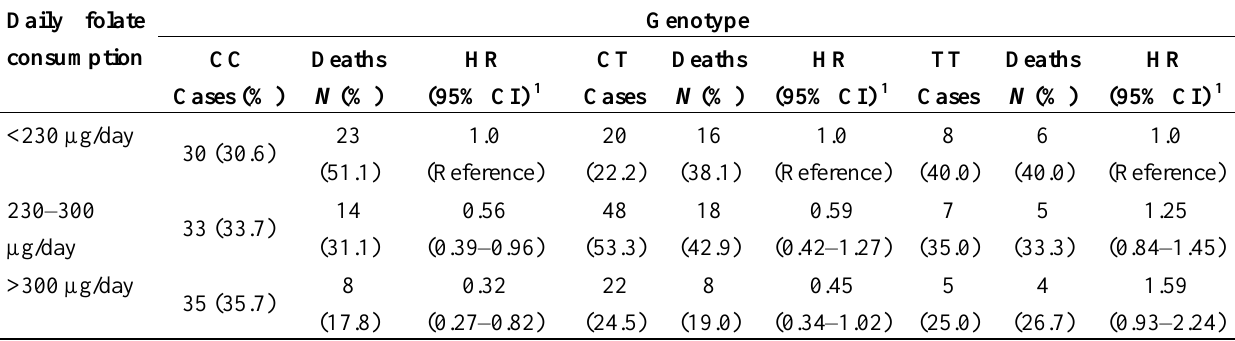
Table 4. MTHFR C677T polymorphisms and ovarian cancer prognosis according to folate intake